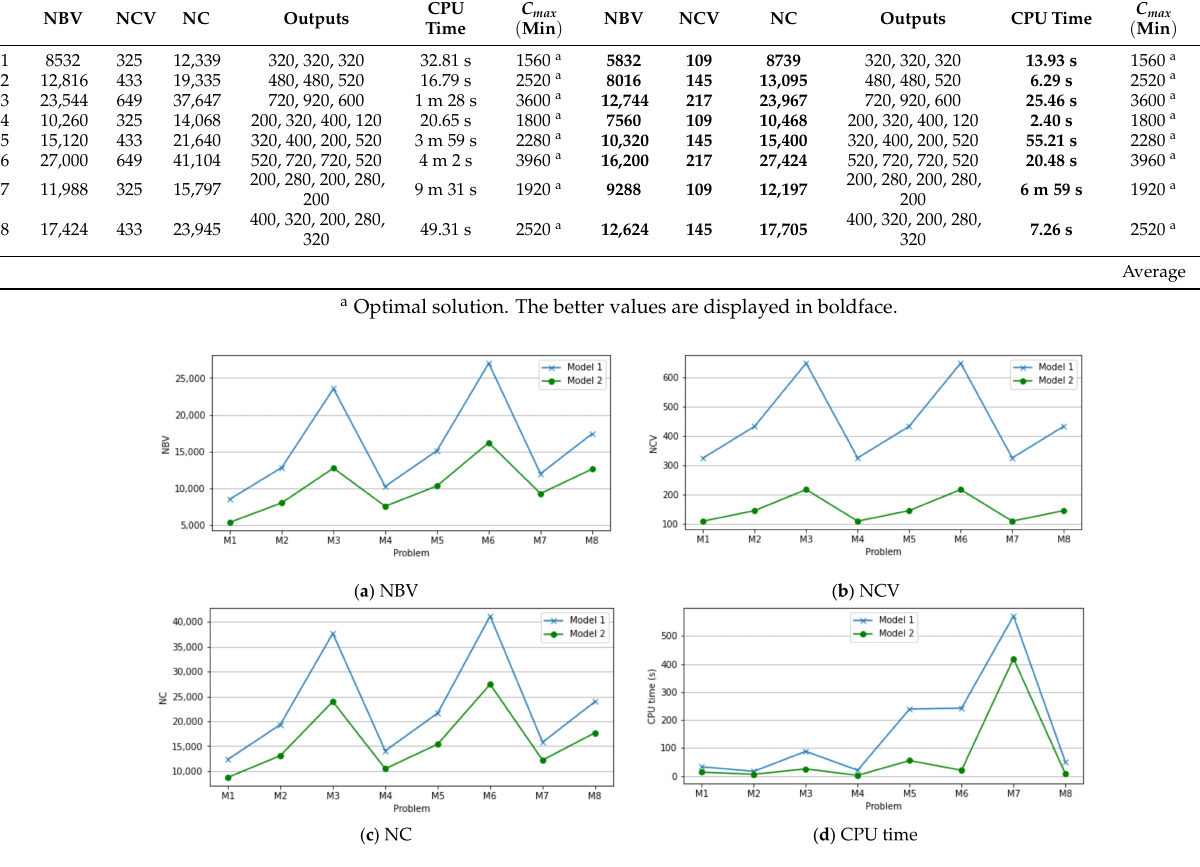
Figure 4. Comparison of the model size, as the ( a ) NBV (number of binary variables), ( b ) NCV (number of continuous variables), and ( c ) NC (number of constraints) and ( d ) the CPU times for solving the medium problems between Model 1 and Model